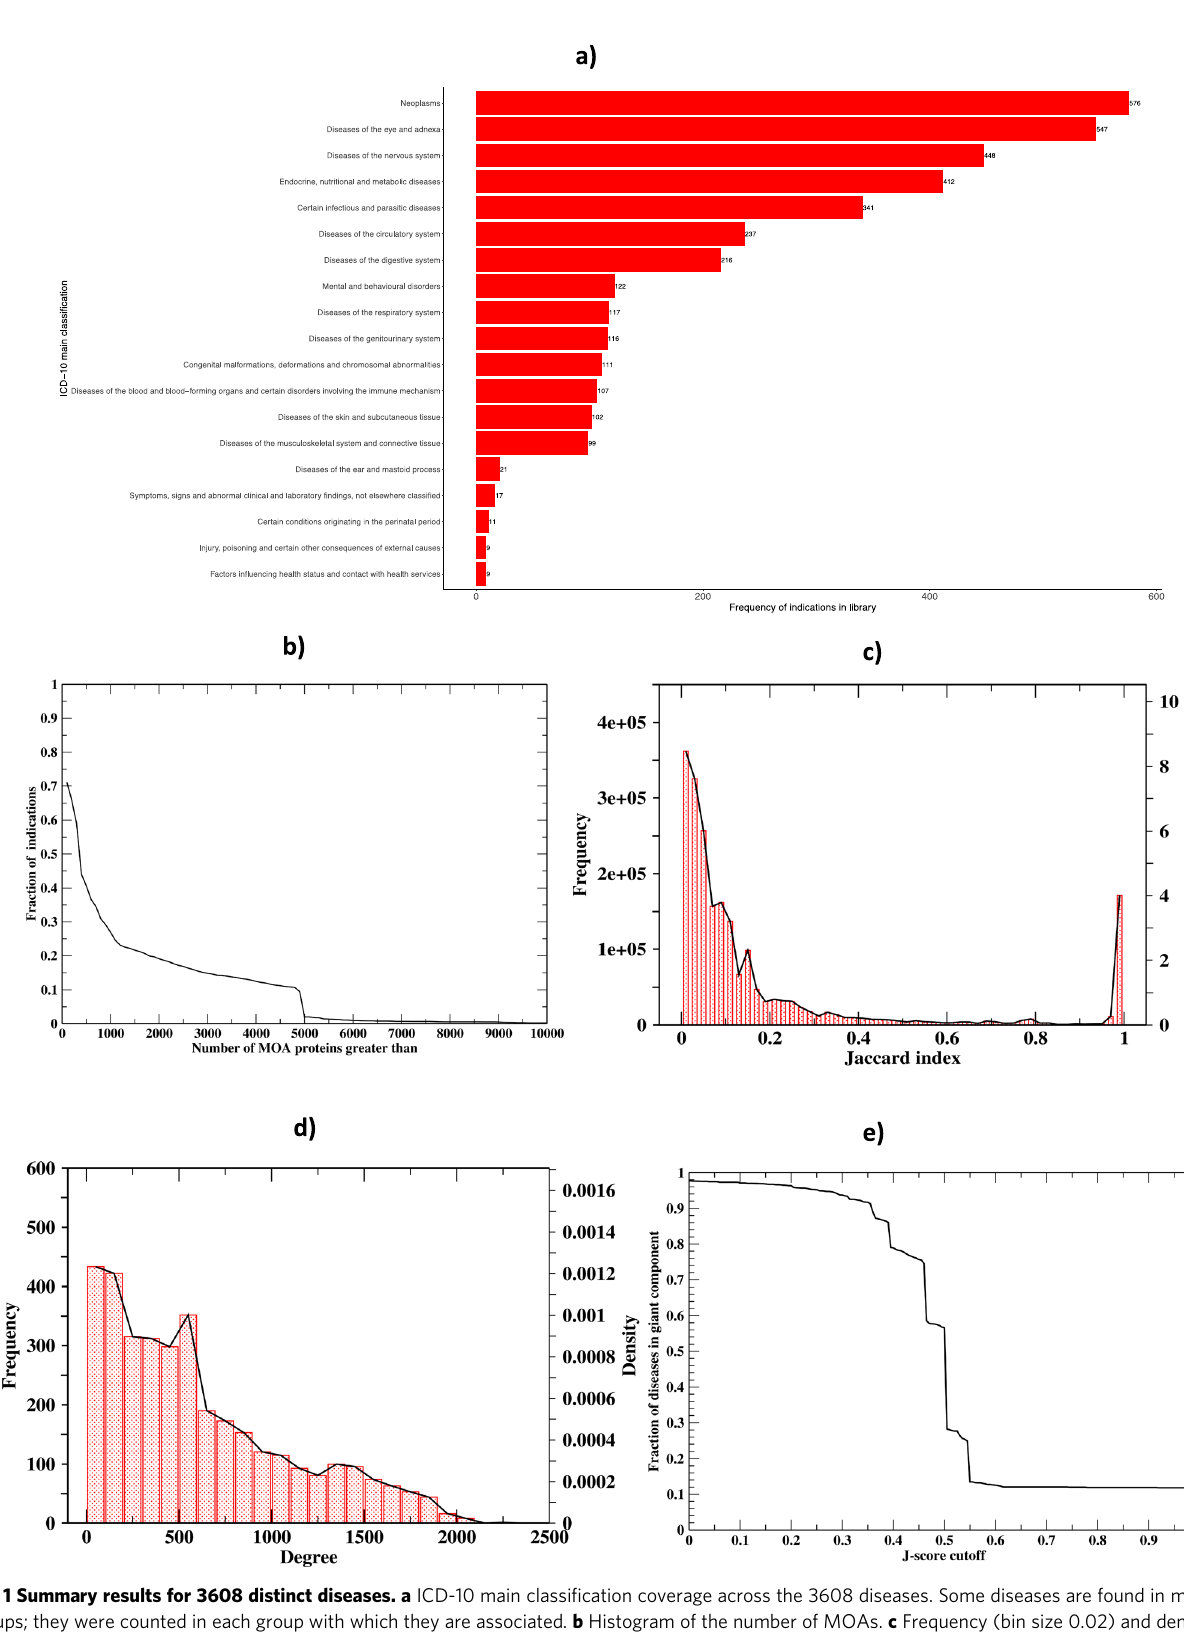
Fig. 1 Summary results for 3608 distinct diseases. a ICD-10 main classi fi cation coverage across the 3608 diseases. Some diseases are found in multiple groups; they were counted in each group with which they are associated. b Histogram of the number of MOAs. c Frequency (bin size 0.02) and density of the J-score for the ~2 million signi fi cant ( q value <0.05), non-redundant disease pairs. d Frequency (bin size = 100) and density of the degree (number of edges) of each disease (node). e Fraction of diseases in the giant component of disease – disease network versus the J-score cutoff.